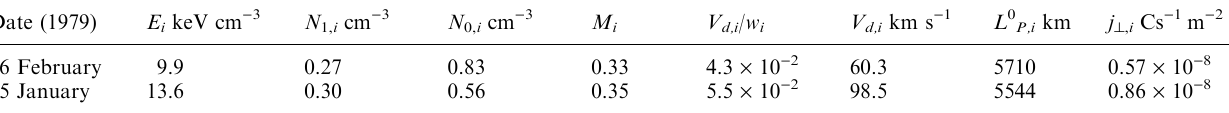
Table 1. Energetic ion parameters at the GEOS-2 position prior to substorm onset Date